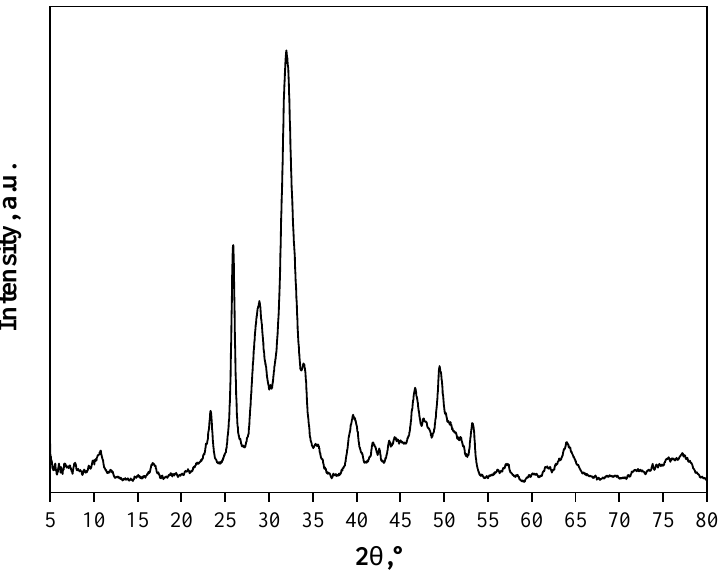
Figure 1. X-ray diffraction pattern of synthesized HAp. Table 1. Data compilation based on ICDD database and Rietveld refinement calculations. Phase